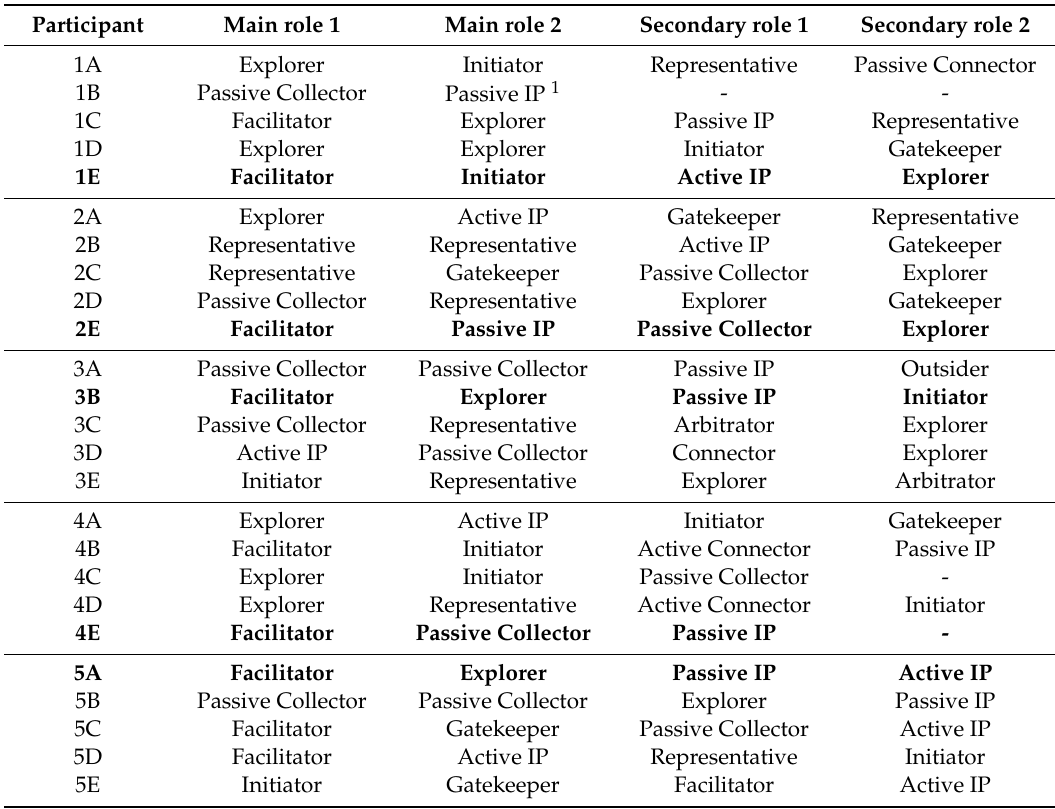
Table 3. Team roles of the student teams